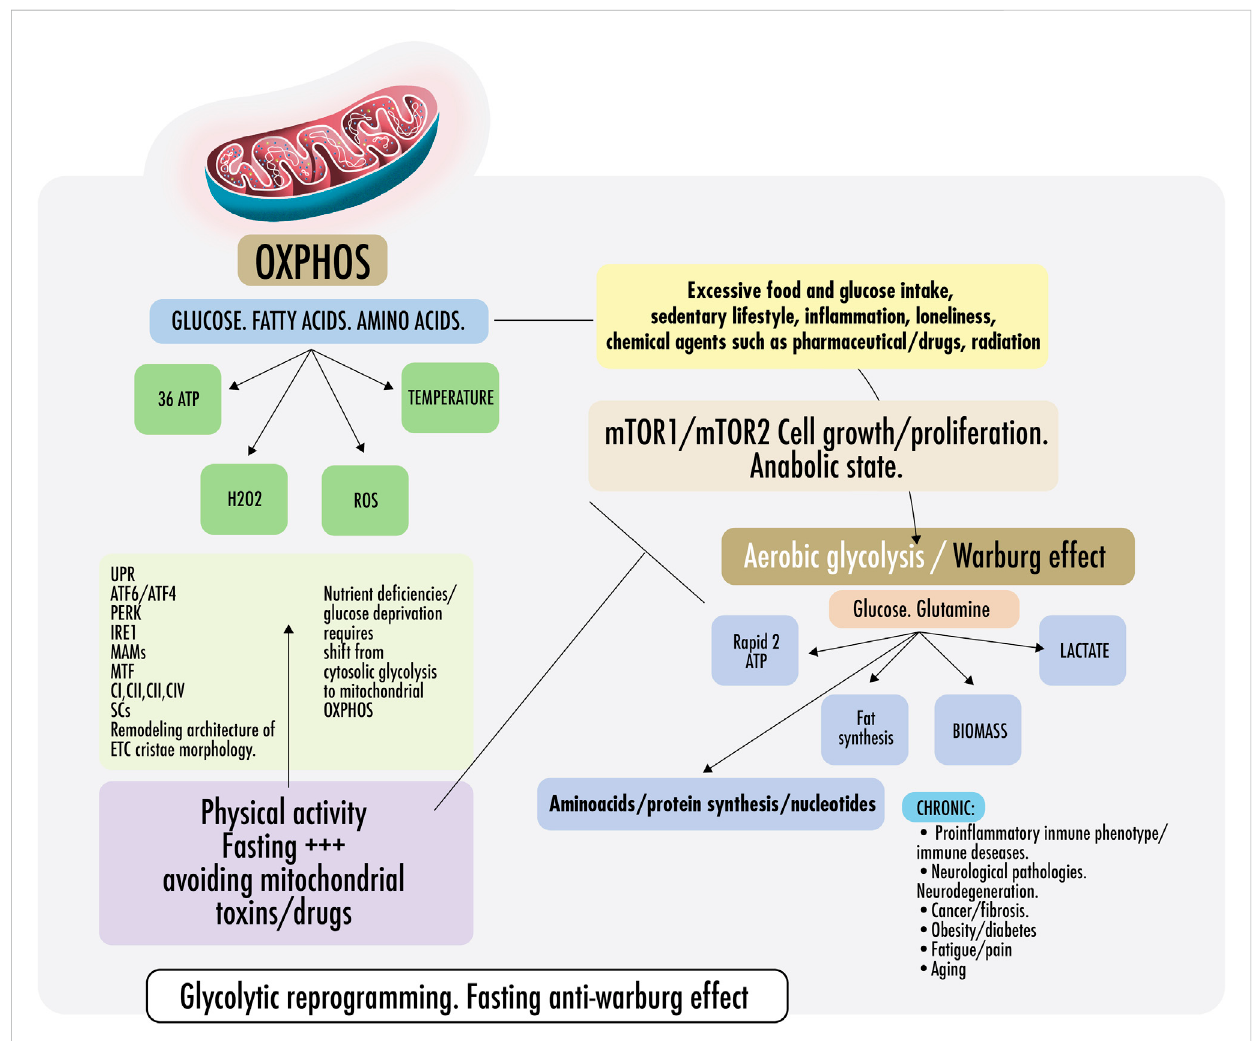
Switch From OXPHOS to aerobic glycolysis. Warburg effect and anti-Warburg effect. Under physiological conditions, cells can change from mitochondrial respiration to cytosolic respiration. Mitochondria allow the ef fi cient production of ATP and regulate temperature, producing ROS (OXPHOS). In the presence of nutrients, cytosolic glycolysis permits cell repair/proliferation without oxidation, which facilitates the production of amino acids, fats, and nucleotides, among others. It is important to keep these processes alternate and intermittent. Right: in pathological states, some risk factors are mentioned, such as in fl ammation, loneliness, glucose surplus, and some medications, which induce a metabolic change from OXPHOS to aerobic glycolysis directed by the mechanistic target of rapamycin if persistently maintained (mTORC1/mTORC2). Both continously activated result in failure of the lysosomal and autophagy mechanisms inducing persistent anabolic state, fi brosis, excess proliferation, and changes in the immunometabolic phenotype that could result in CNCDs. Left: to restore physiological states and recover OXPHOS, exercise and fasting achieve an anti-Warburg effect. During nutrient deprivation, cells demand OXPHOS to increase bioenergetic capacity by driving a decrease in fi ssionand remodeling intheelectron transportchain(ETC)orcristaemorphology. Itisnot yetclear,but probably,ETC architectureremodelingis driven becauseofendoplasmicreticulum ERstressduringfastingbecauseofthedisruptionofproteinfolding andglycosylation. Animbalance inproteinfolding capacity starts the unfolded protein response (UPR) mechanism, activating transcription factor (ATF6/ATF4), protein kinase R- (PKR-) like ER kinase (PERK), and inositol-requiring enzyme (IRE1) to re-establish ER homeostasis and maintain protein folding. Physical contact sites termed mitochondria- ER-associated membranes (MAMs) regulate calcium homeostasis, mitochondrial fi ssion, lipid metabolism, autophagy, and in fl ammasome activity. ER communicates with the OXPHOS system to increase ATP supply and promote protein homeostasis. Exercise also induced mitochondrial cristae remodeling or shaping, improving the activity of respiratory chain complexes (CI, CII, CIII, and CIV) in the inner membrane and mitochondrial